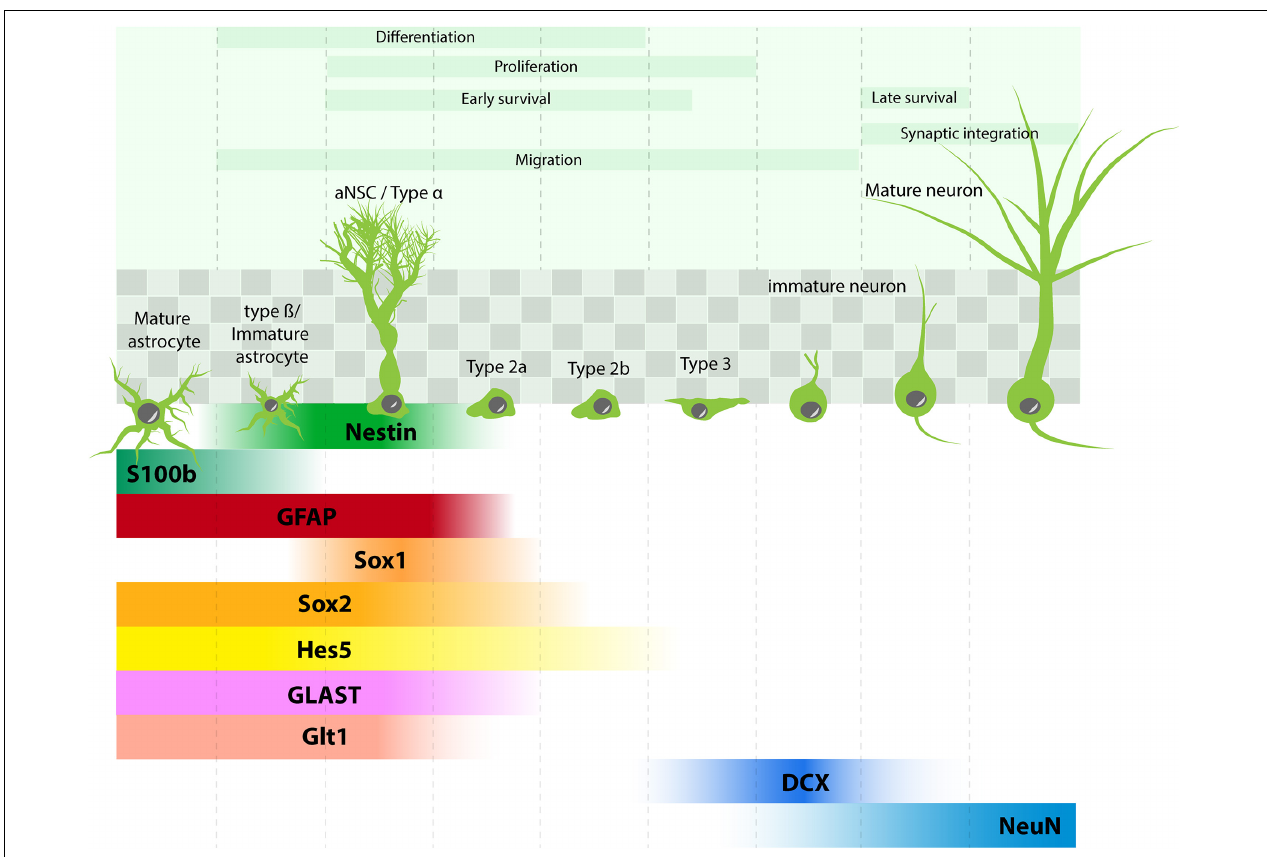
FIGURE 1 | Adult hippocampal neurogenesis: process and molecular marker expression. aNSC (type α cells) are found in the subgranular zone of the dentate gyrus (shaded squares) and give rise to different progenies : type β cells (immature astrocytes), astrocytes, types 2–3 progenitors, which differentiate into neurons. Molecular markers in each cell type are depicted in comparison with markers expressed in mature